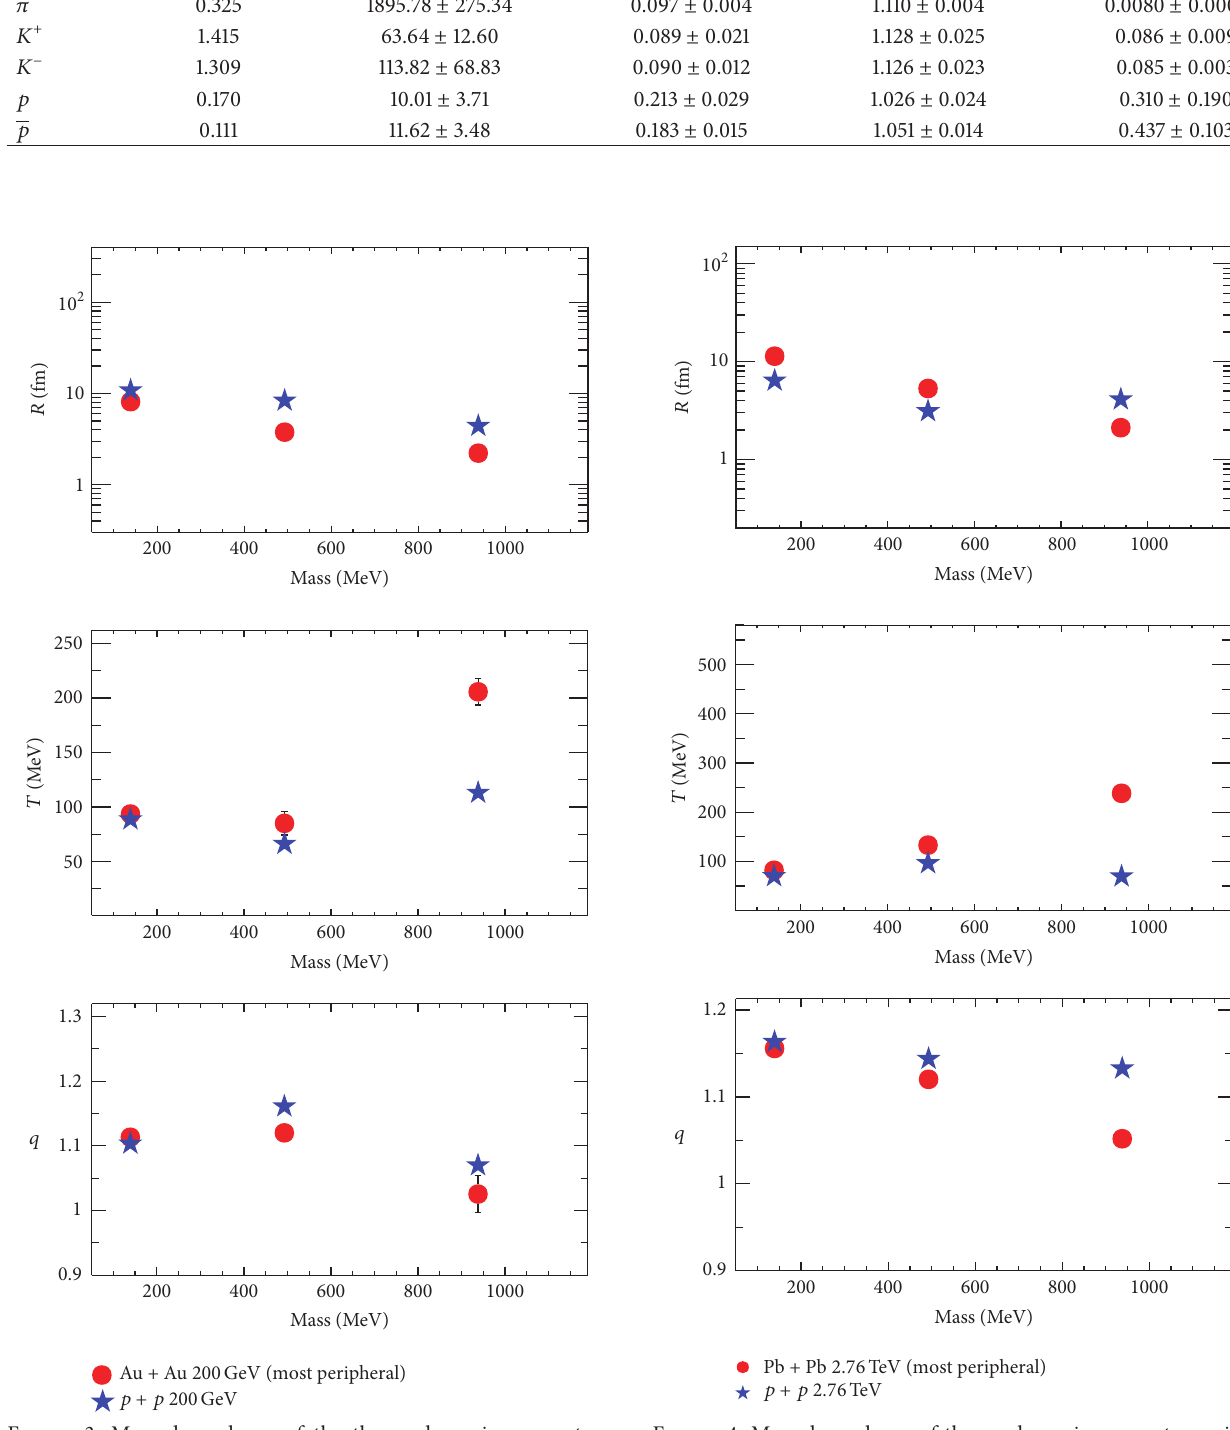
Figure 4: Mass dependence of thermodynamic parameters using (7) for most peripheral Pb + Pb and 𝑝 + 𝑝 collisions at √ 𝑠 NN = 2.76